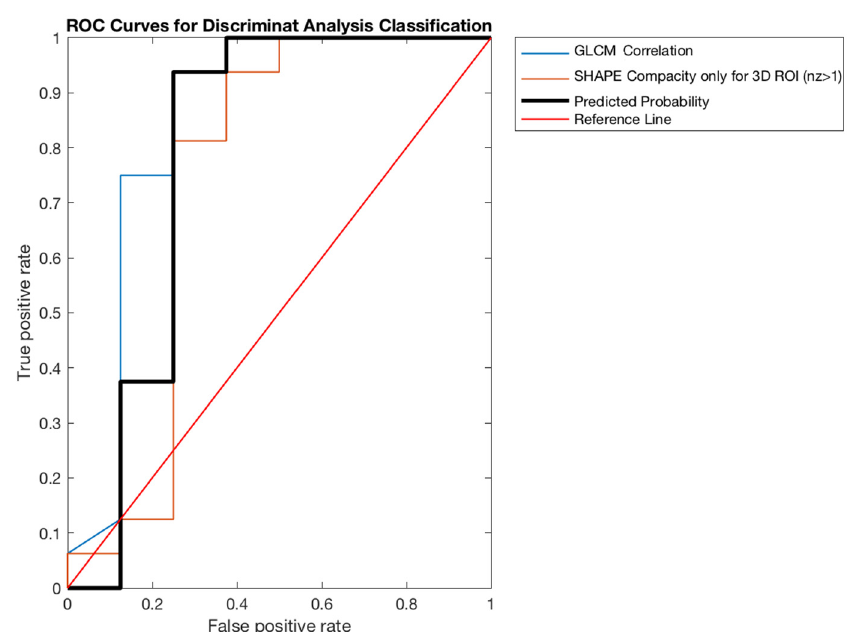
Figure 5. ROC curve for VOI (SIEMENS patients’ group).